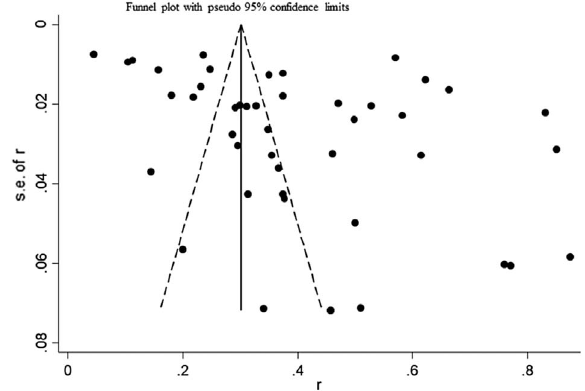
Figure 3. Funnel plot with pseudo 95% con fi dence limits intervals for the examination o publication